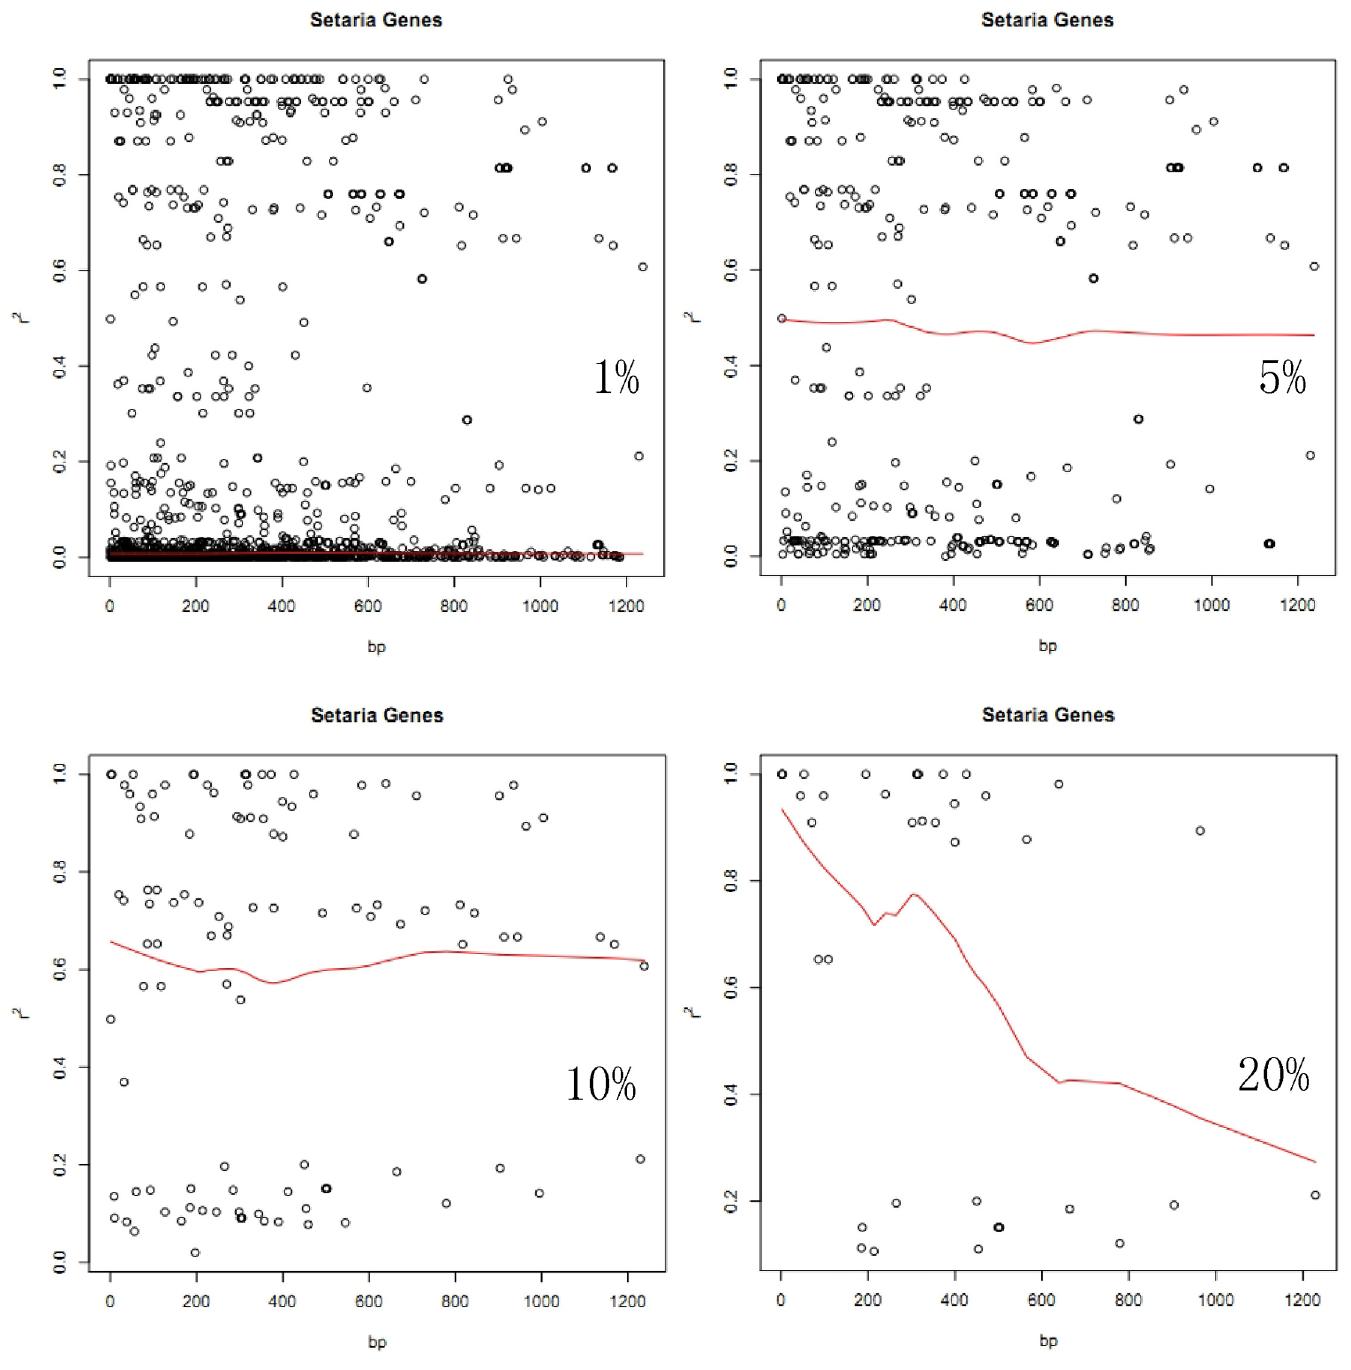
Fig 3. Plots of squared allele frequency correlations ( r 2 ) by physical distance between sites in foxtail millet. An SNP frequency filter of 1%, 5%, 10%, 20% was used. The red line in each plot depicts the lowess smoothed line that summarized the observed data in LD.